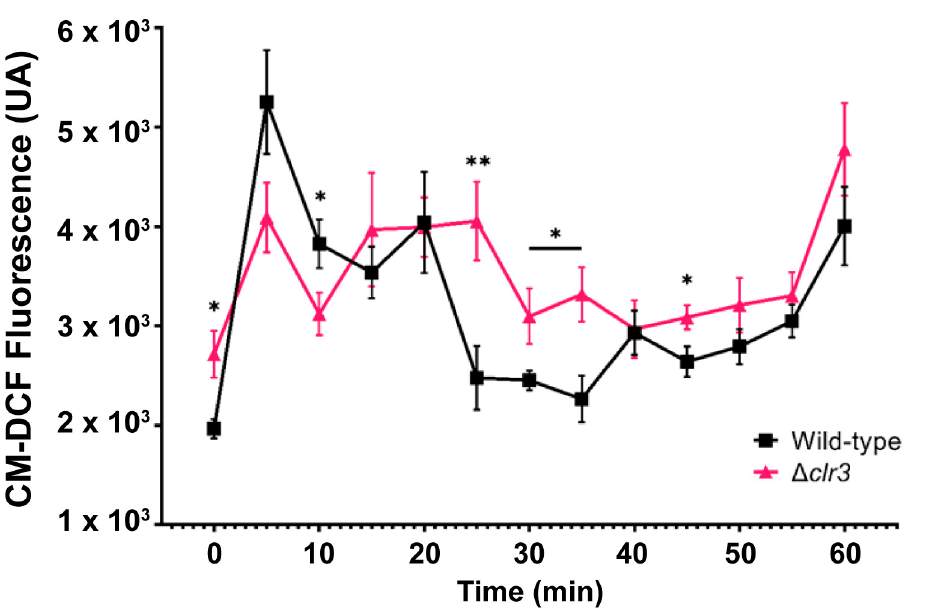
Figure 5. Intracellular ROS levels in the wild-type and mutant strains without (0 min) and after exposure to 5 mM of H 2 O 2 . The data represent the average value of eight biological replicates. The error bars represent the standard deviation, * p ≤ 0.05, ** p ≤ 0.01 (one-way ANOVA, significance level 0.05). Both fungal strains were cultivated in minimum media for 24 h in a 96-well plate. H 2 O 2 was added to growth media to a final concentration of 5 mM before incubation with 0.25 mM CM-H 2 DCFDA probe for 30 min at 30 °C and then washed twice with PBS.